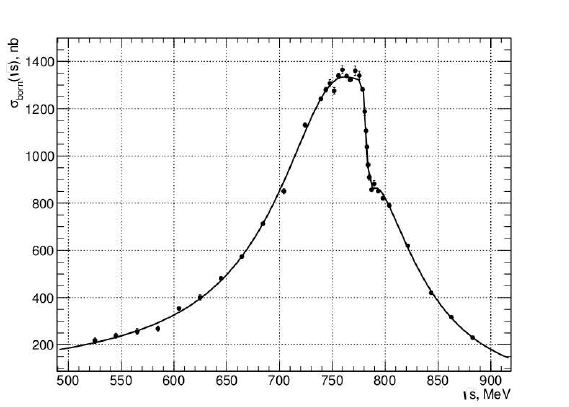
Figure 1. The preliminary cross section of the process e + e − → π + π − measured by SND. The curve is the VDM